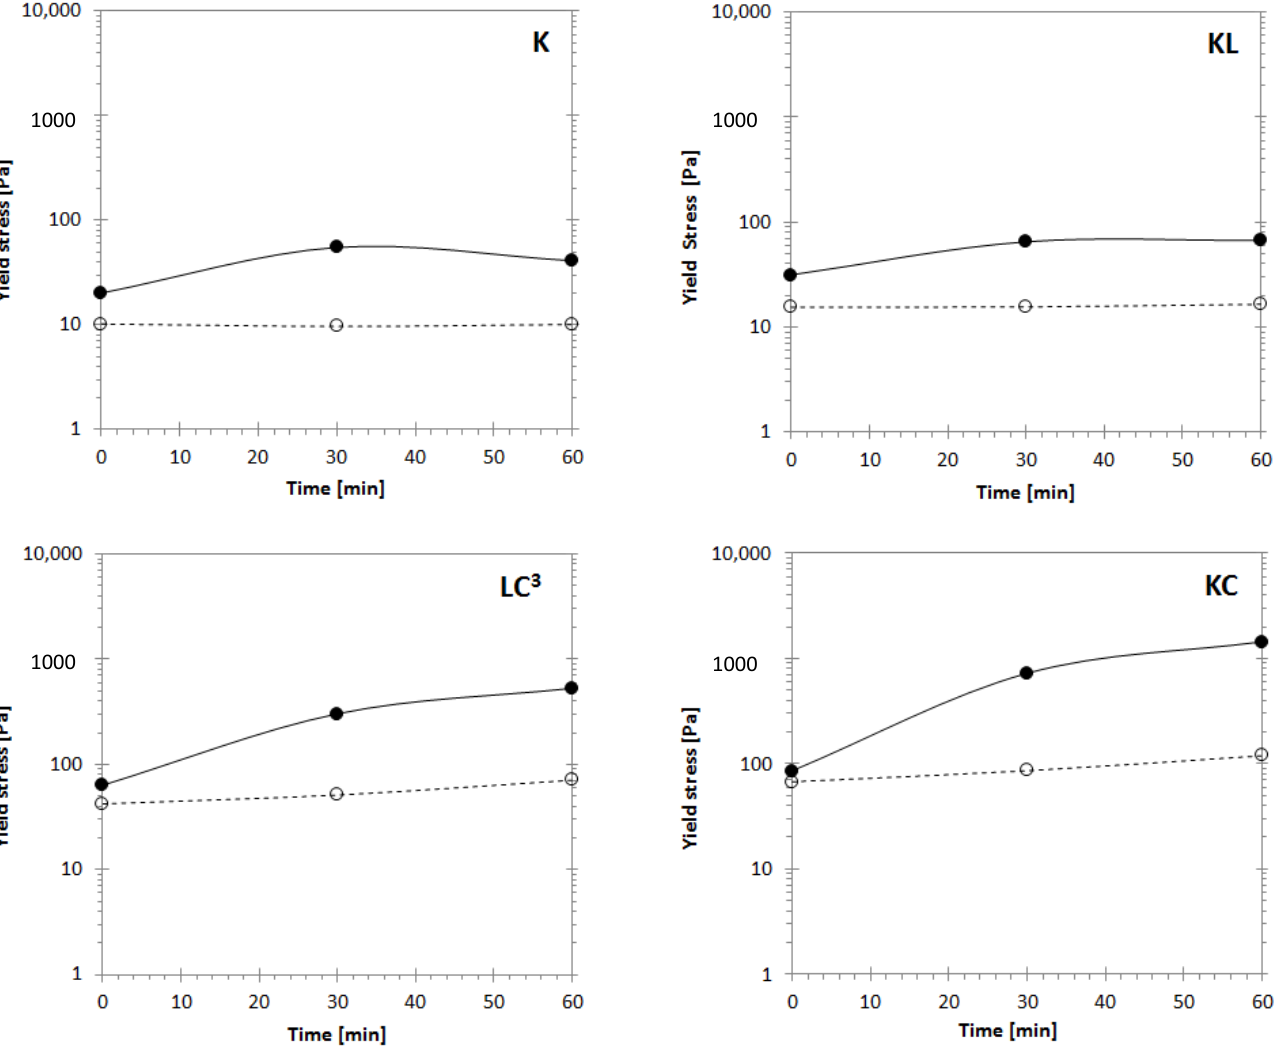
Figure 3. Effect of resting time on static yield stress τ S (filled circles) and dynamic yield stress τ D (open circles) determined from the flow curves.